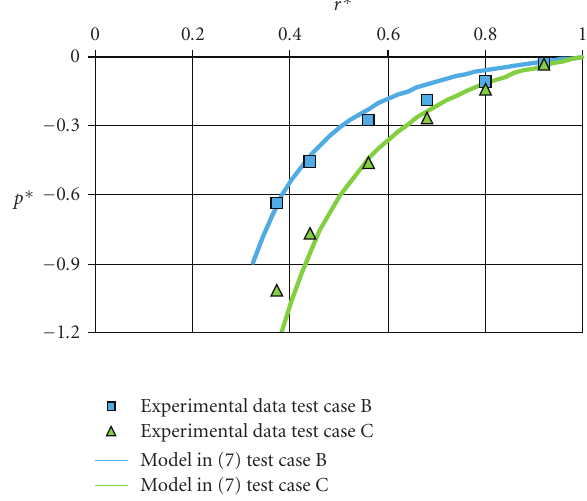
Figure 4: Radial pressure